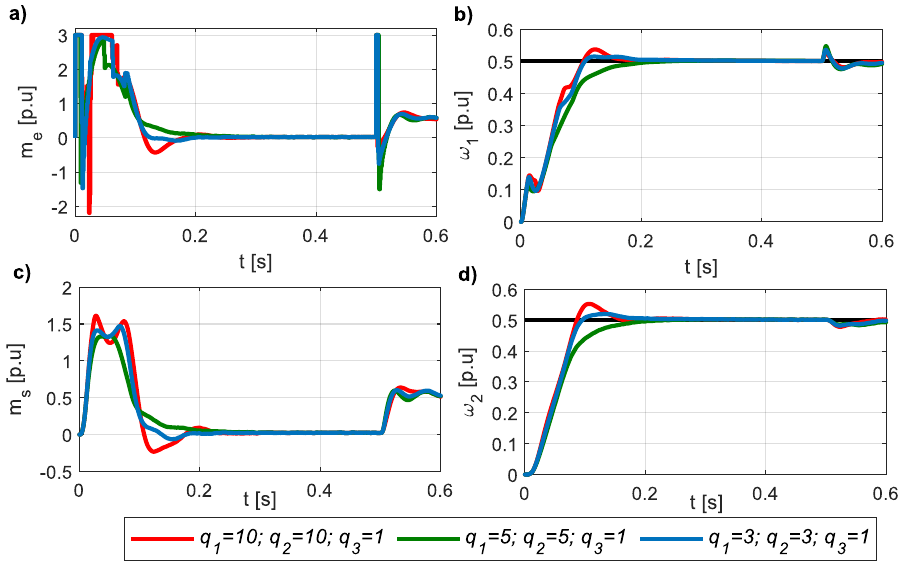
Figure 8. Impact of objective function weights on the dynamic properties of the system: ( a , c ) torque, ( b , d ) speed.